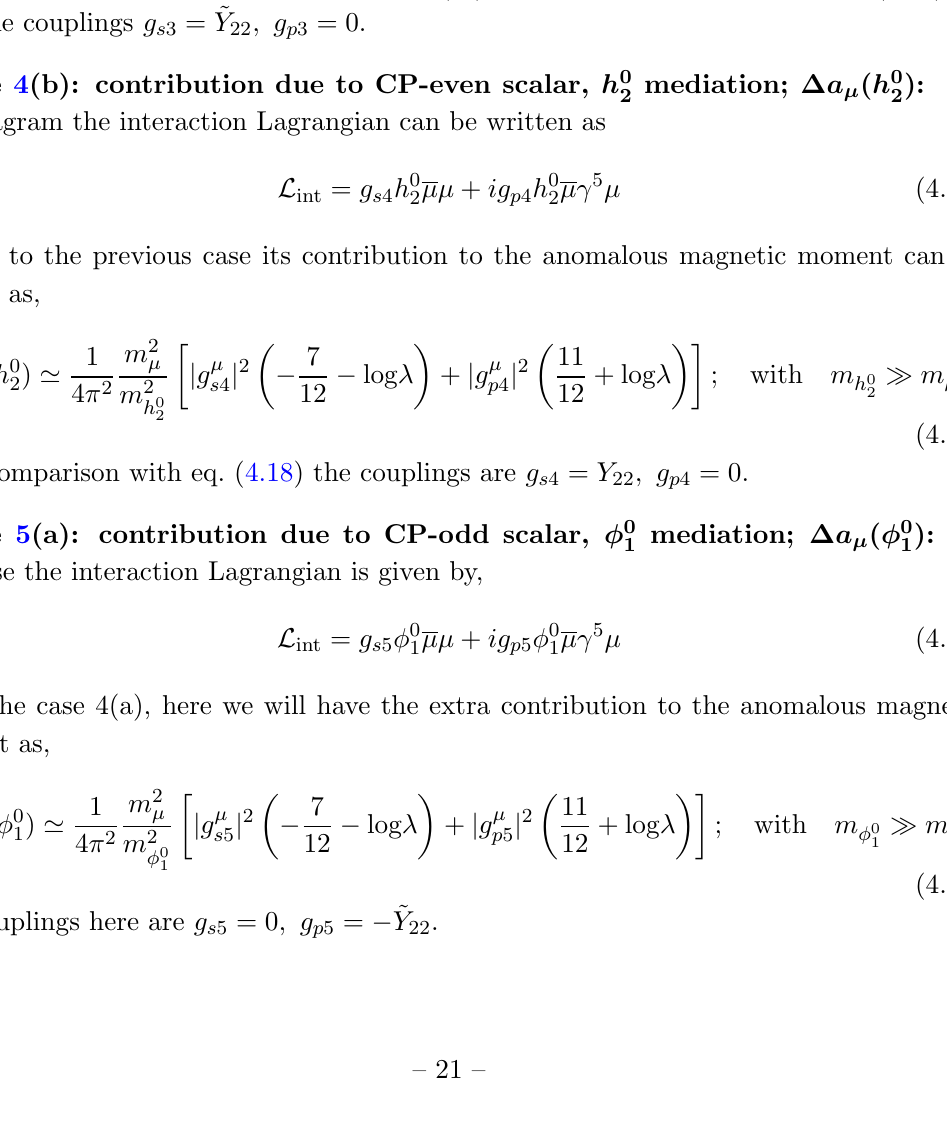
; (cid:30) 0 with muons. 1 2